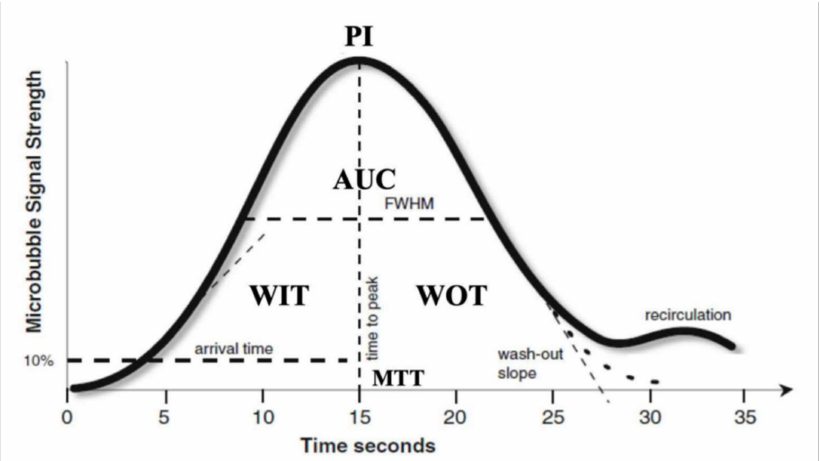
Figure 1. An example of a time–intensity curve after CEUS examination and an explanation of the most important parameters. Microbubble signal strength is usually measured using absolute intensity units and time in seconds. Abbreviations: time to peak, TP; wash-in time, WIT; wash-out time, WOT; peak intensity, PI; mean transit time, MTT; area under the curve,